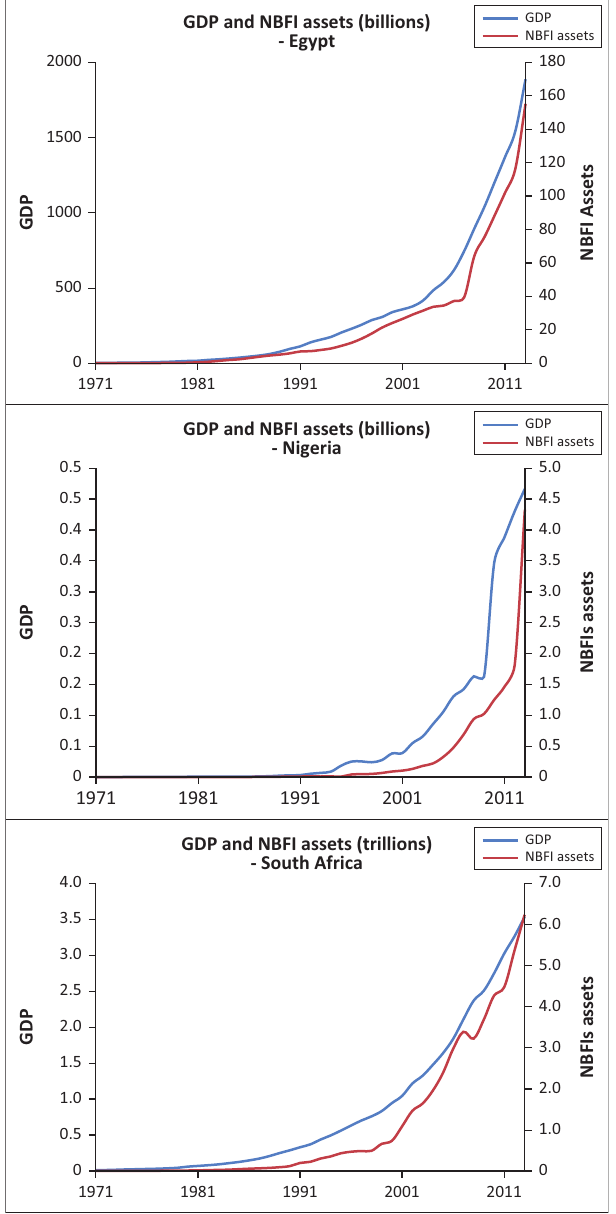
FIGURE 1: Co-movement of non-bank financial institution assets and gross domestic product for Egypt, Nigeria and South Africa: